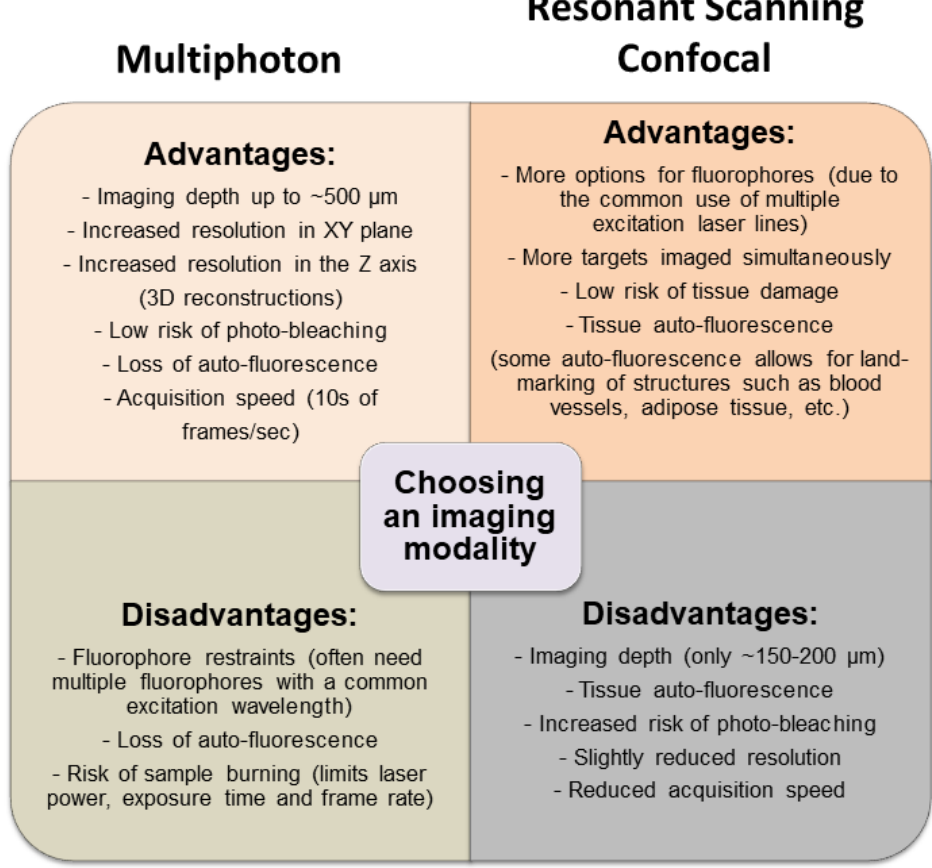
Figure 6. Comparing resonant scanning confocal versus multiphoton IVM imaging for studying cell recruitment and behavior in the tumor microenvironment (TME). The advantages and disadvantages of each imaging modality are listed to provide a basis for choosing which technique would best suit a specific